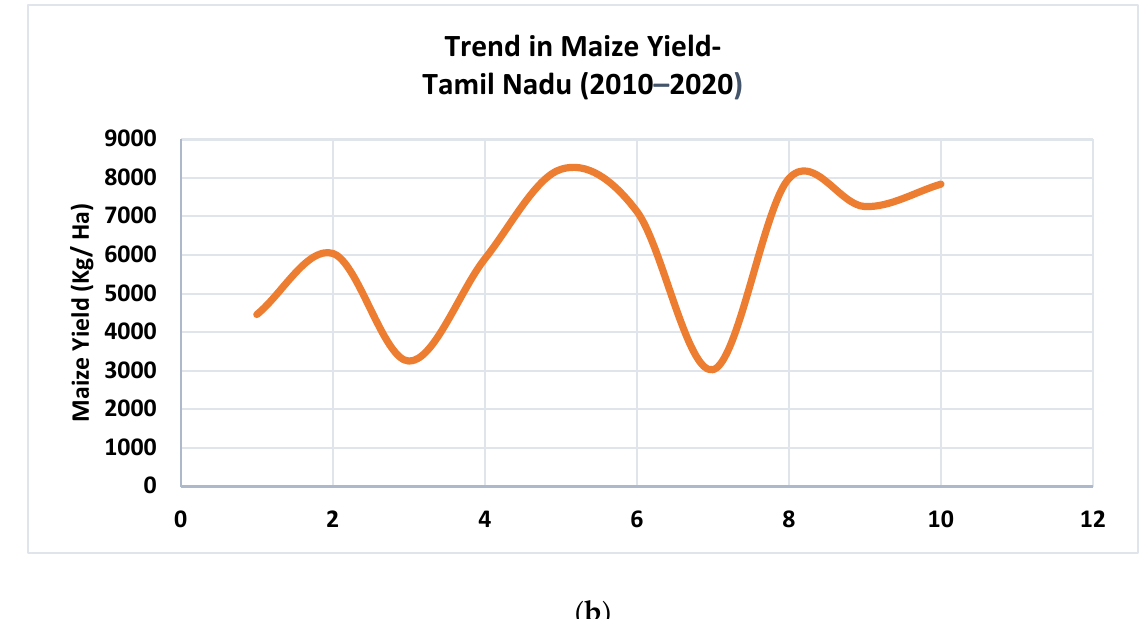
Figure 3. ( a , b ) Trends in the maize area and yield in the study area, respectively.